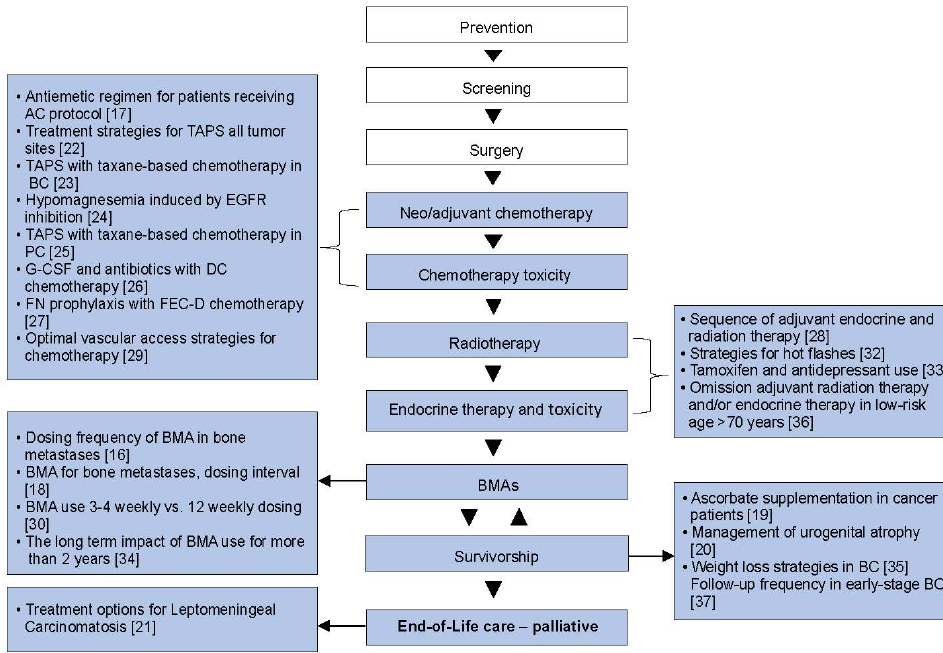
Figure 2. The cancer journey: where the systemic reviews fit. BC, breast cancer; BMAs, bone- modifying agents; DC, docetaxel–cyclophosphamide; EGFR, epidermal growth factor receptor; FEC-D, 5-fluorouracil, epirubicin; PC, prostate cancer; TAPS = taxane-associated pain syndrome